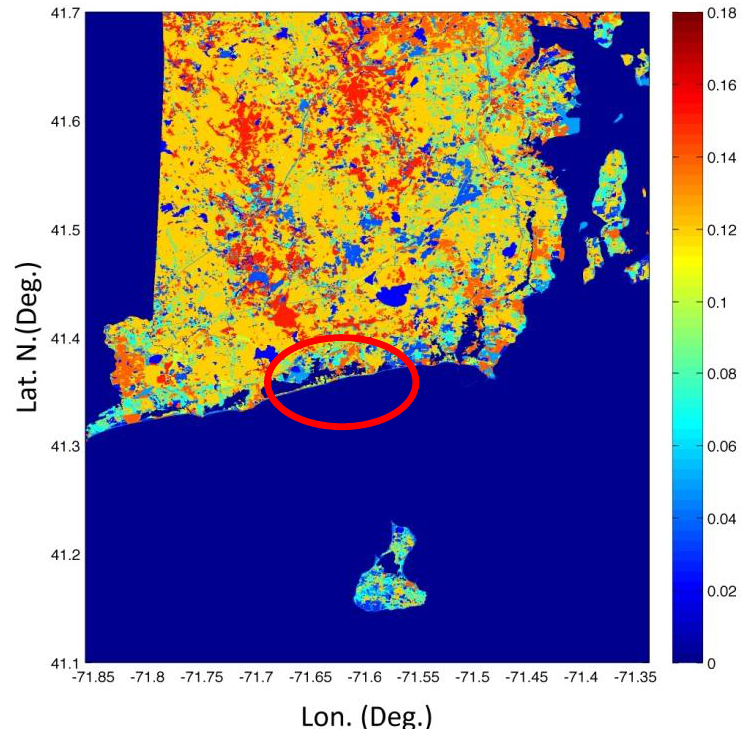
Figure A2. Map of the Manning coefficient associated to the land use and vegetation cover in Rhode Island [26]. A value of 0.02 is employed over ocean and open water. The study area is circled in red. J. Mar. Sci. Eng. 2017 , 5 , 10